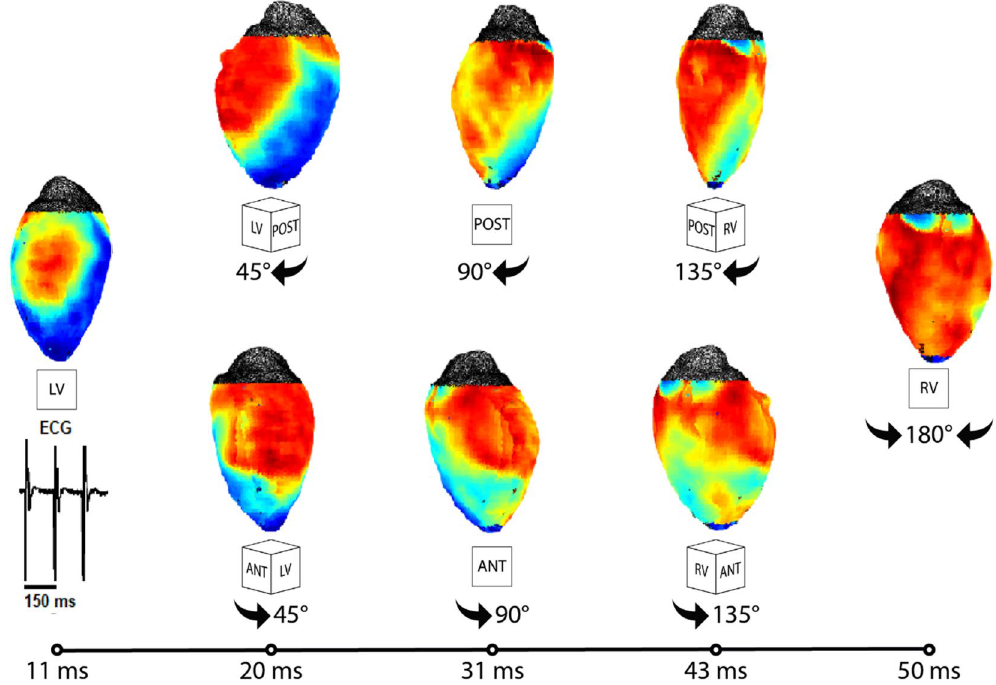
Figure 8. Representative mouse panoramic optical data. ( A ) The time course of pacing activation is tracked using membrane